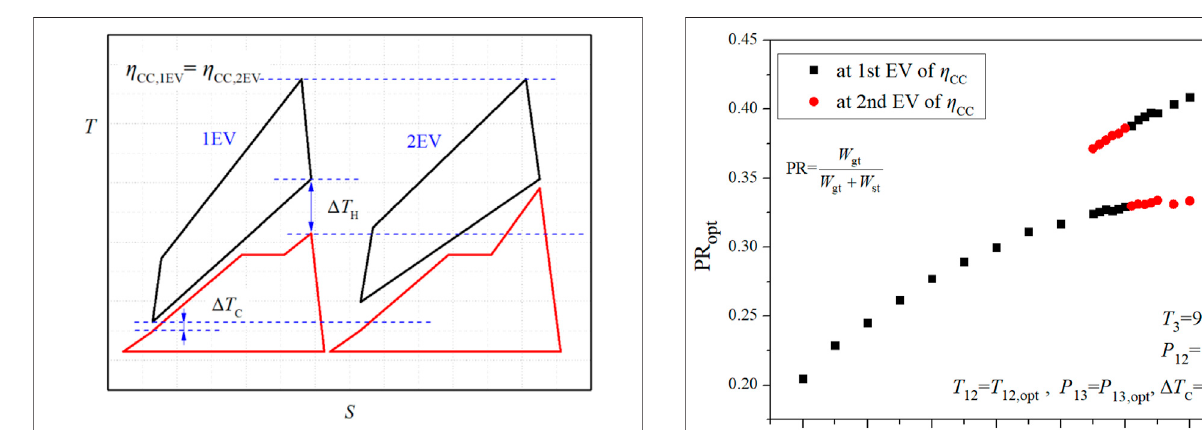
FIGURE 8 | Temperature-entropy diagram of two combined cycles with equal extreme ef fi ciency values.